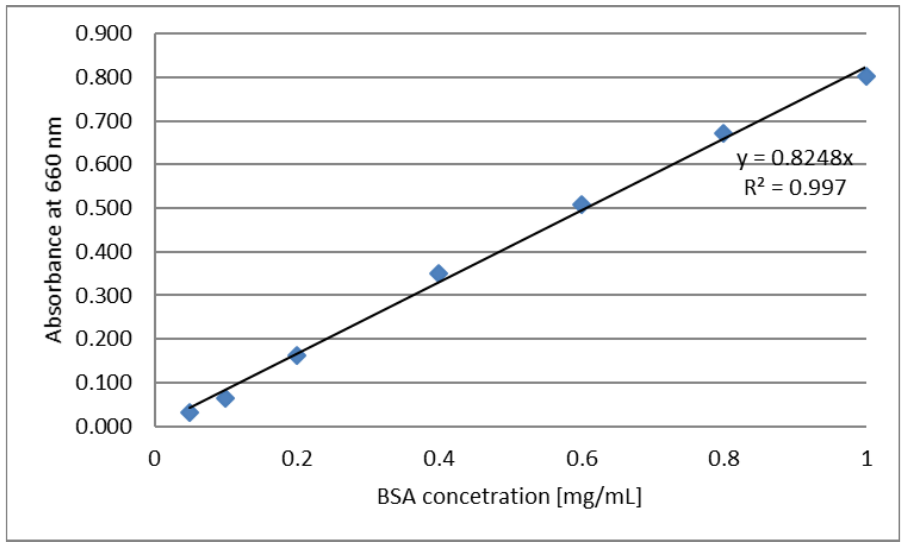
Figure 7. Calibration curve—absorbance dependence on Bovine Serum Albumin (BSA) concentration.